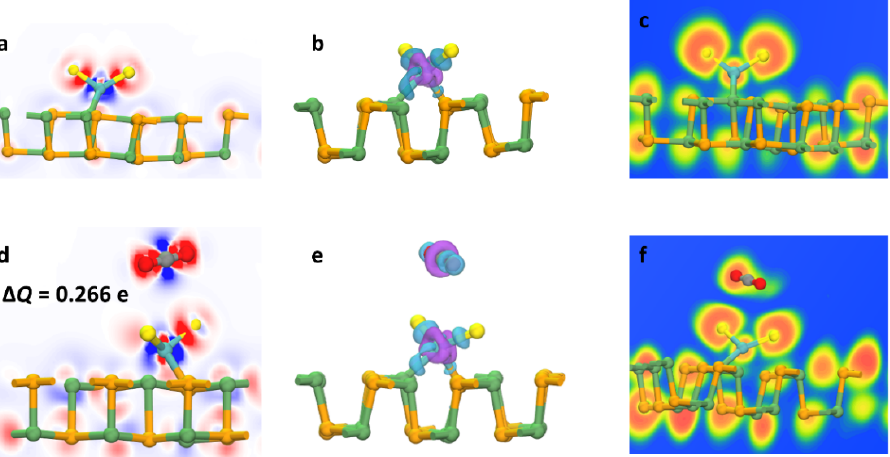
Figure 3. DCD ( a ), CDD ( b ) and ELF ( c ) on the MoS 2 –GeSe monolayer and DCD ( d ), CDD ( e ) and ELF ( f ) on the CO 2 /MoS 2 –GeSe monolayer.